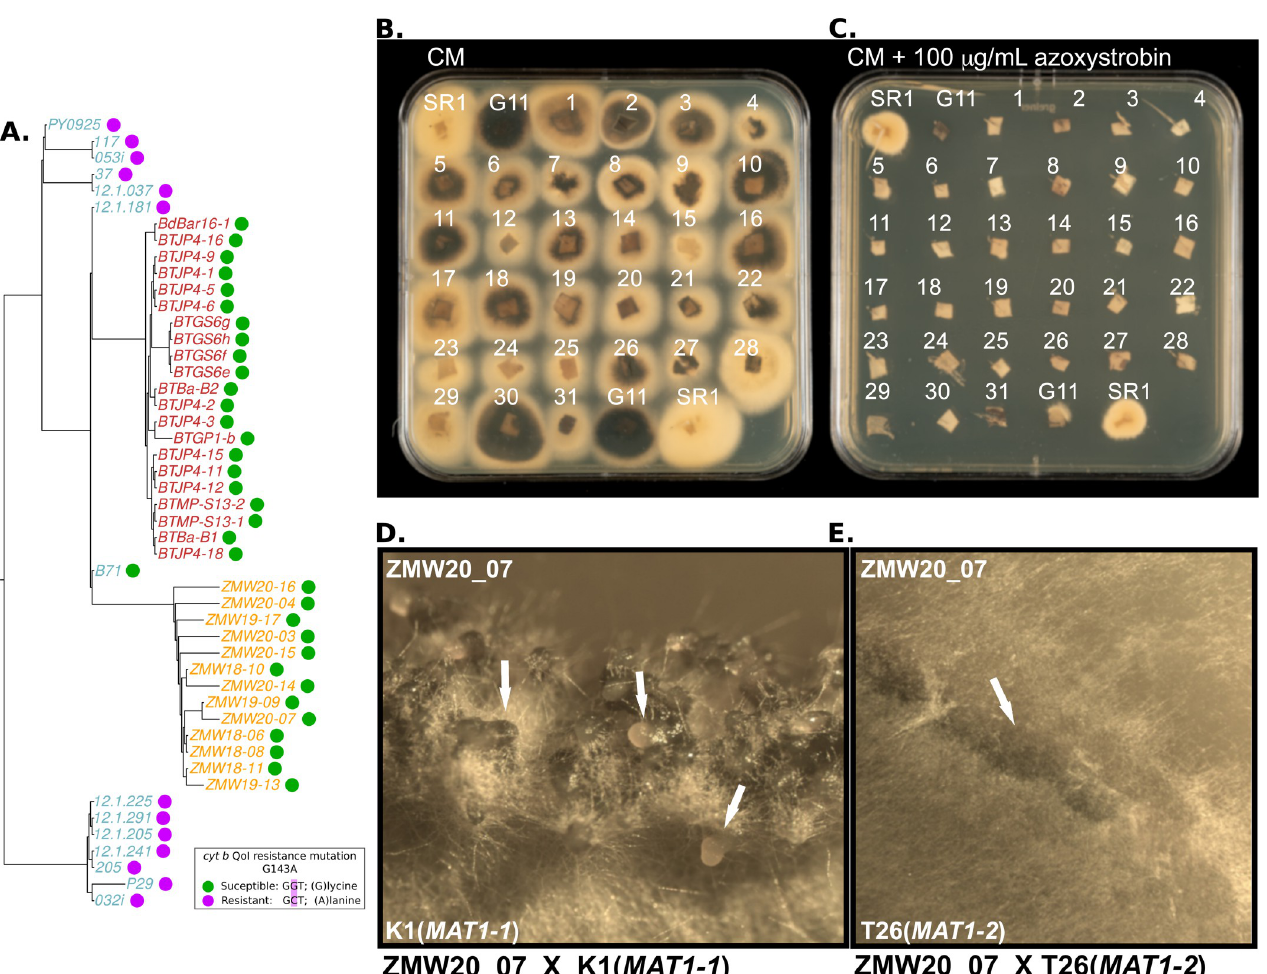
Fig 4. Zambian wheat blast isolates are susceptible to strobilurin fungicides but at risk from resistance development and can mate with prevailing finger millet blast isolates. (A) The tree describes, based on nuclear SNPs, the phylogenetic relationship among wheat-infecting blast isolates belonging to three clonal lineages: B71, PY0925, and P29. The tree was rooted in the midpoint. The colored dots next to each isolate label represent the resistant-type allele of the mitochondrially encoded cyt b gene associated with a susceptible or resistant predicted phenotype as shown in the inset. (B, C) 4 × 10 6 spores of the Zambian strain ZMW20-14 were exposed to 100 μ g ml 1 azoxystrobin to obtain an azoxystrobin-resistant strain with the G143A mutation (SR1). This strain, the rice infecting strain Guy11 (G11), and the wheat-infecting strains numbered 1–31, respectively, BTBa-B1, BTBA-B2, BTGS6e, BTGS6f, BTGS6g, BTGS6h, BTGP1-b, BTMP-S13-1, PY6047, BTJP4-1, BTJP4-2, BTJP4-3, BTJP4-5, BTJP4-6, BTJP4-9, BTJP4-11, BTJP4-12, BTJP4-15, BTJP4-16, BTJP4-18, ZMW18-06, ZMW20-07, ZMW18-08, ZMW19-09, ZMW18-10, ZMW18-11, ZMW19-13, ZMW20-14, ZMW20-15, ZMW20-16, and ZMW19-17 were grown for 4 days at 25˚C on CM in the absence (A) and presence (B) of azoxystrobin indicating that all the Zambian and Bangladeshi isolates have the “strobilurin susceptible” genotype as anticipated by their CYTB sequences. (D) Zambian isolate ZMW20-7 (MAT-1-2) successfully produced perithecia when crossed with a finger millet blast isolate K1 (MAT-1-1) but (E) ZMW20-7 was unable to produce perithecia when crossed with a finger millet blast isolate T26 of the same mating type (MAT-1-2). Photos taken by the authors. The data underlying this figure can be found in https://doi.org/10.5281/zenodo.7590238. SNP, single nucleotide